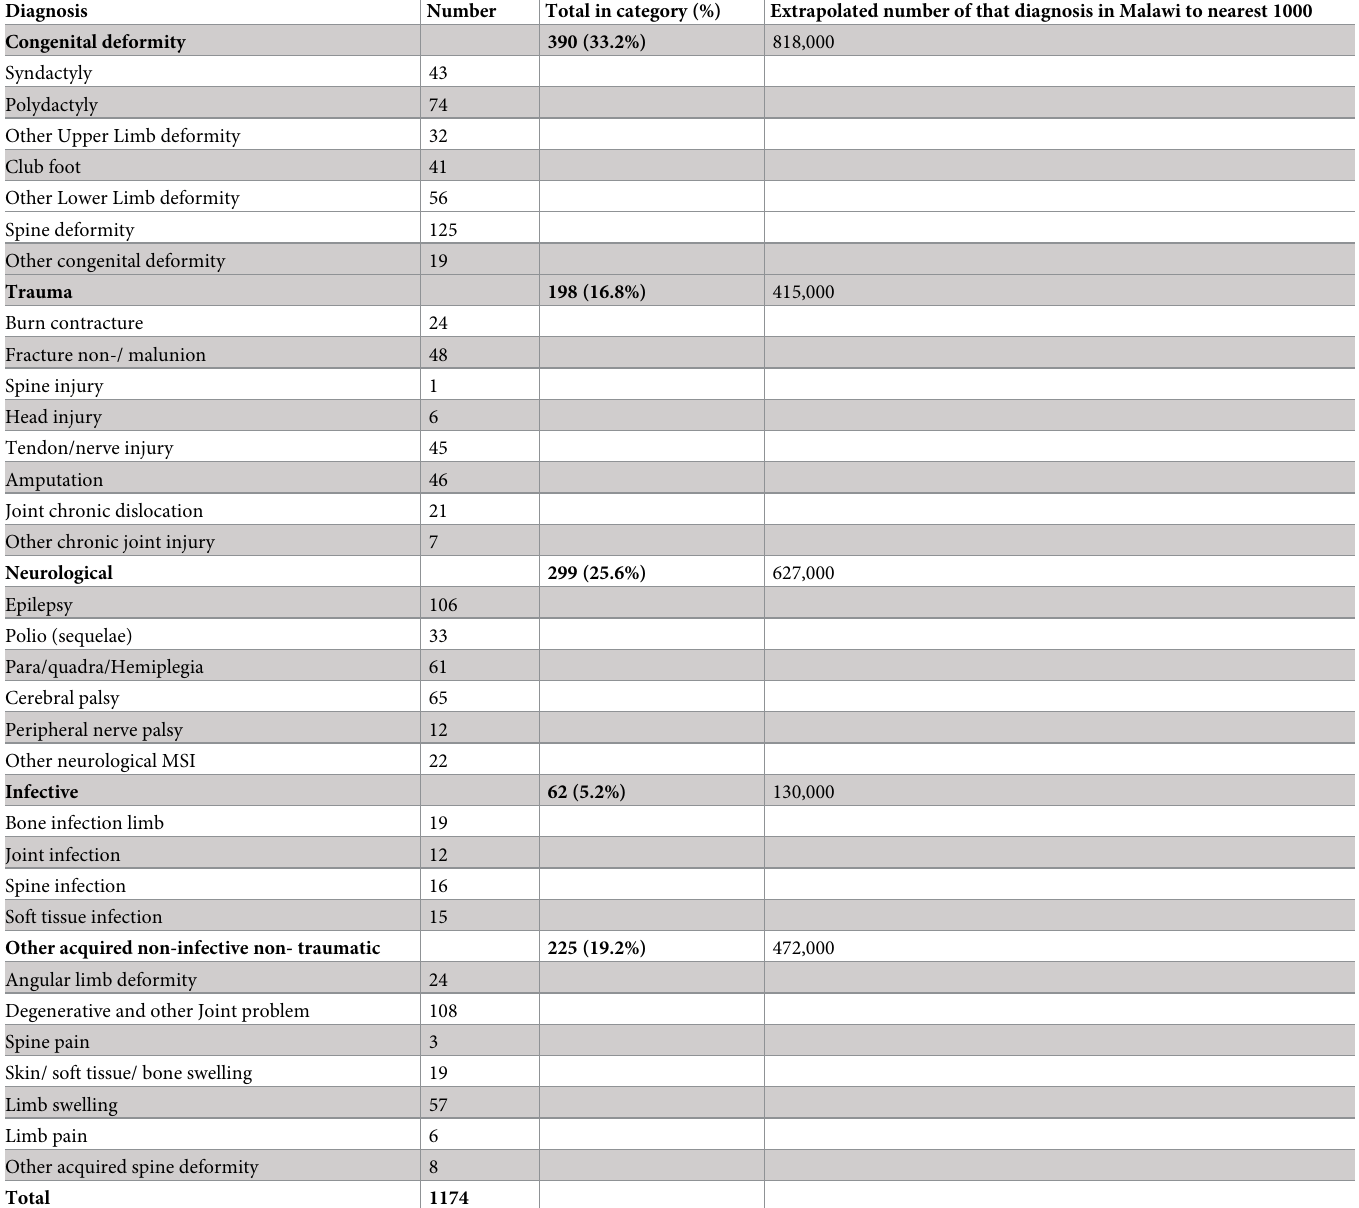
Table 7. Cause of MSI in survey, and extrapolated to population of Malawi.